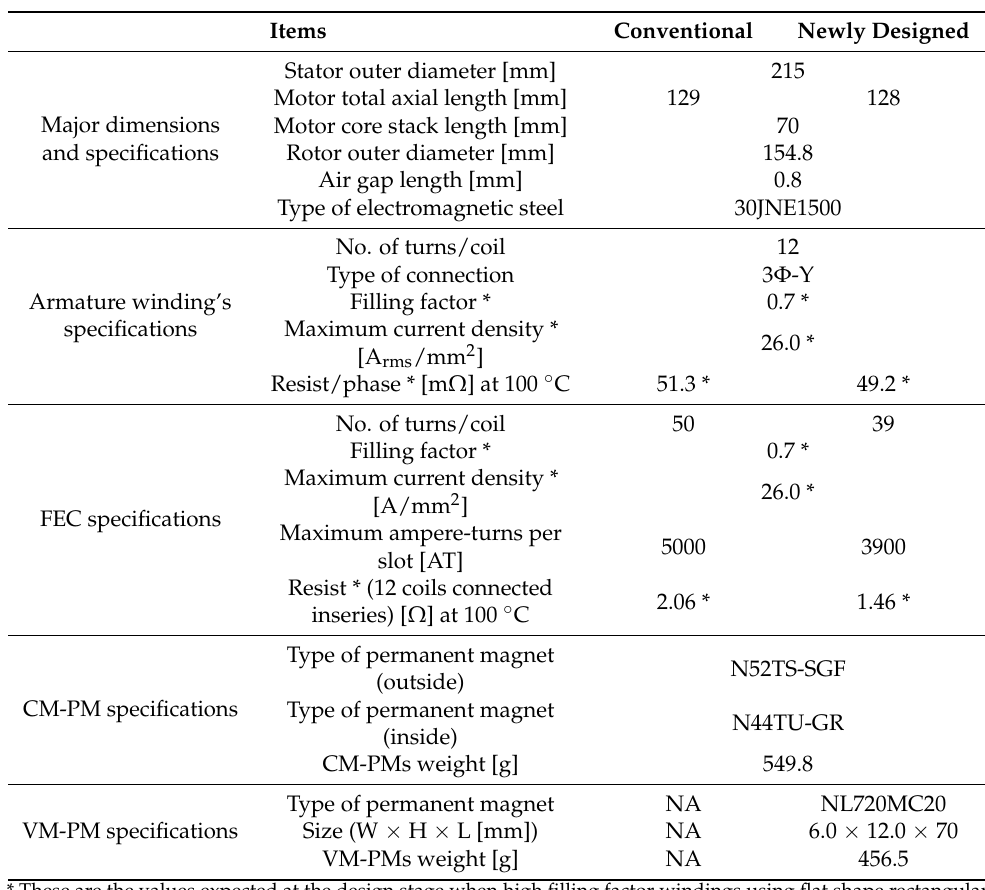
Table 5. Specifications of designed new HEFSM with VM-PMs. ©2020 IEEE. Reprinted with permis-